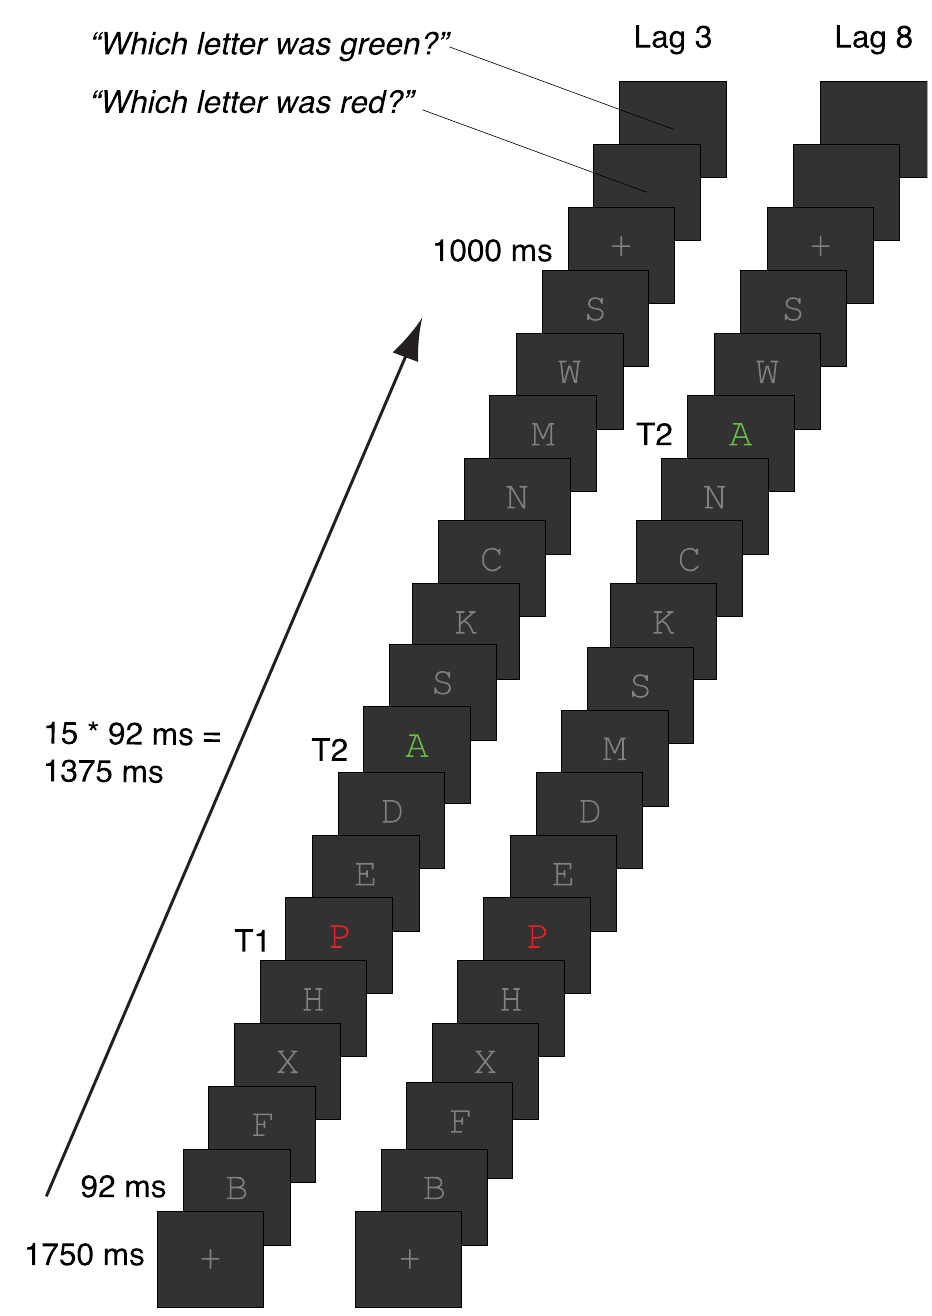
Fig 2. Attentional blink task. Participants viewed rapid serial visual presentation streams of 15 letters, all of which were distractors (gray letters) except for T1 and T2. T1 was presented in red at position 5; T2 was presented in green and followed T1 after 2 distractors (lag 3, inside the AB window) or 7 distractors (lag 8, outside the AB window). At the end of the trial, participants reported the identity of T1 and then T2 (self-paced).